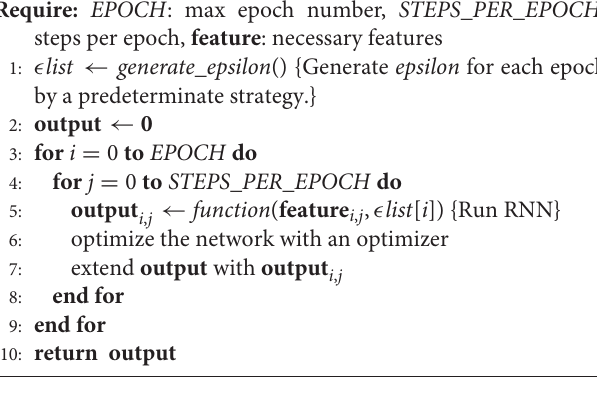
Algorithm 1: Scheduling Algorithm: schedule the ǫ across